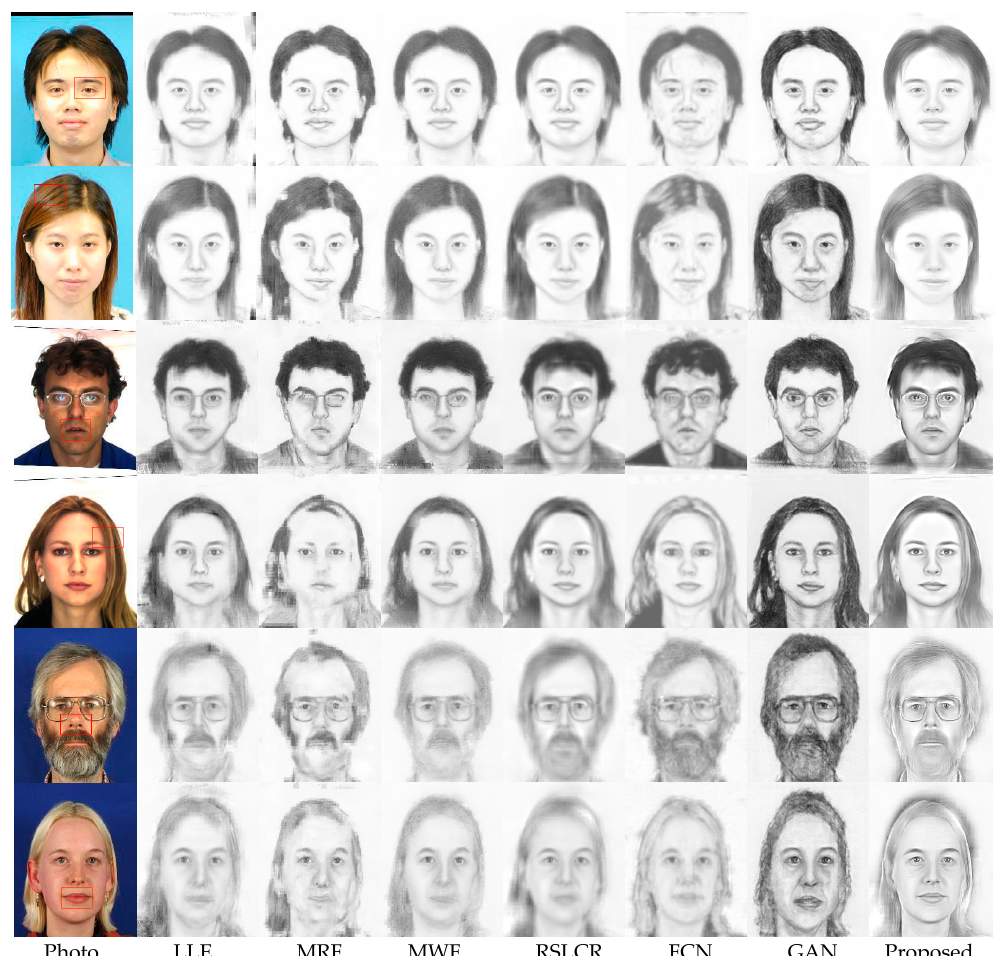
Figure 3. Synthesized sketches on the CUFS dataset by locally linear embedding (LLE) [7], Markov